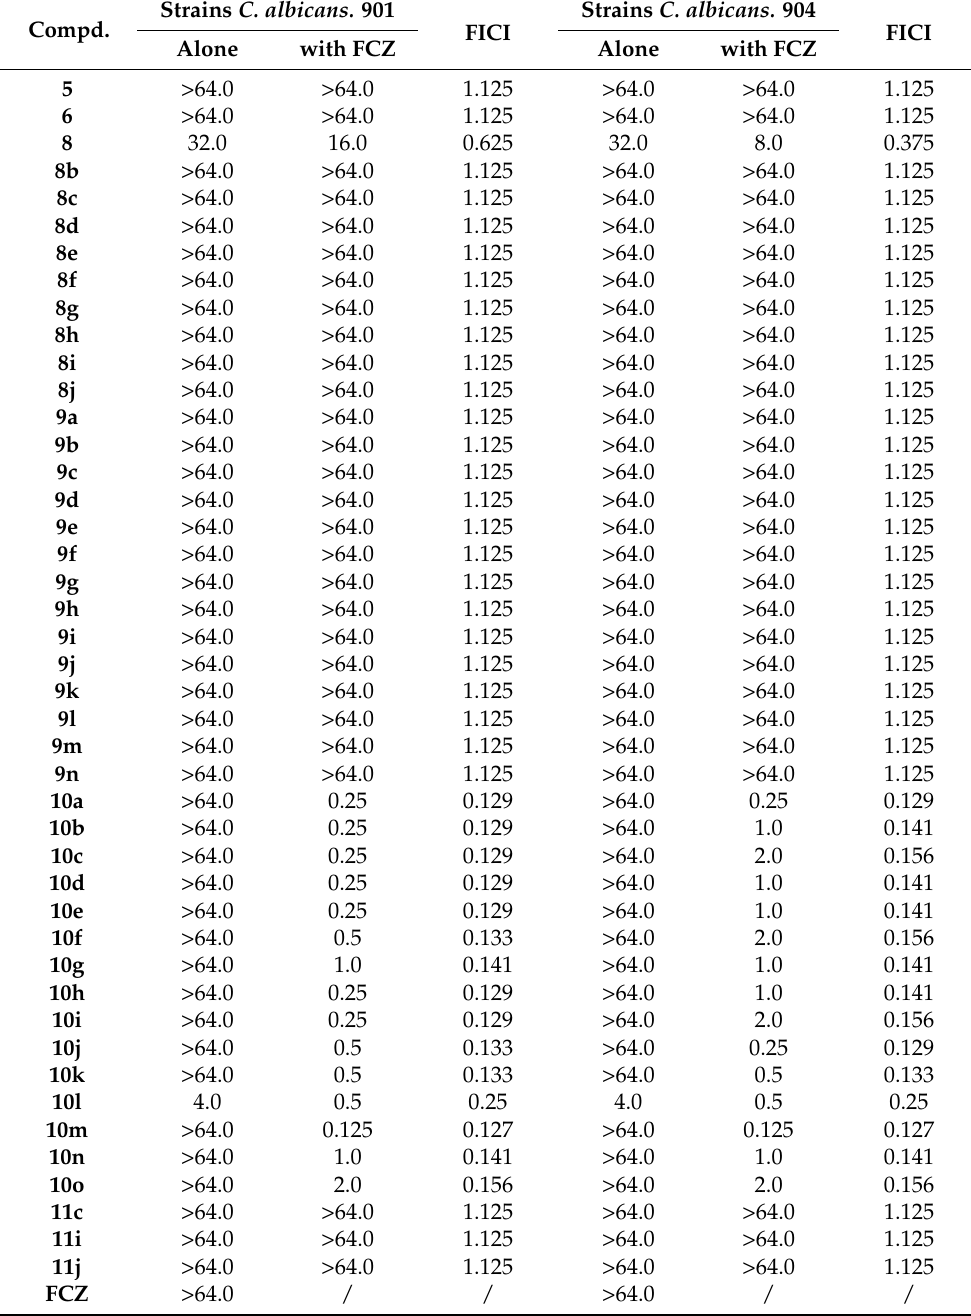
Table 1. In vitro antifungal activity of 1,3,5-triazines derivatives used alone or in combination with FCZ (8.0 µ g/mL) against FCZ-resistant C. albicans strains (MIC 80 , µ g/mL, 48